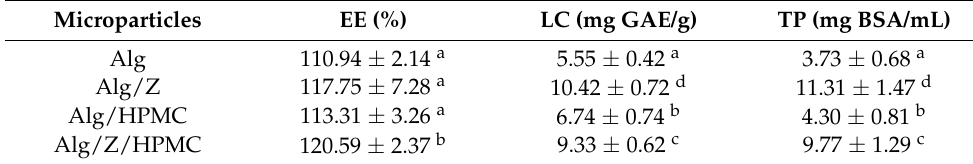
Table 5. Functional properties of microparticles with different coating materials (encapsulation efficiency (EE), loading capacity (LC), and total protein content (TP)). Microparticles EE (%) LC (mg GAE/g) TP (mg BSA/mL)